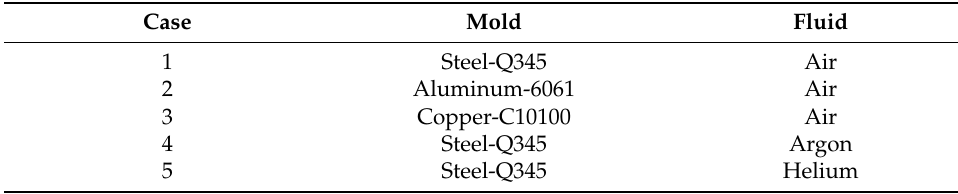
Table 4. Combinations of metal and fluid.